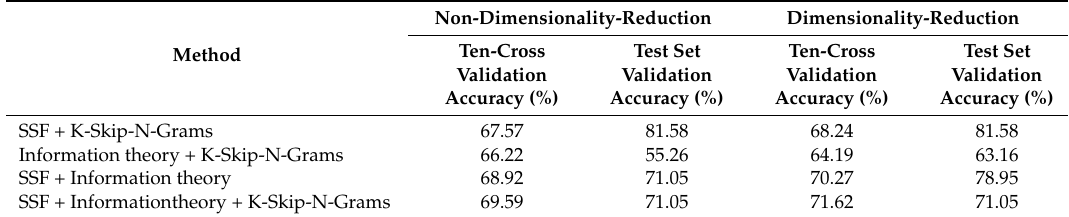
Table 2. Results of protein classification based on multiple features and PDB186